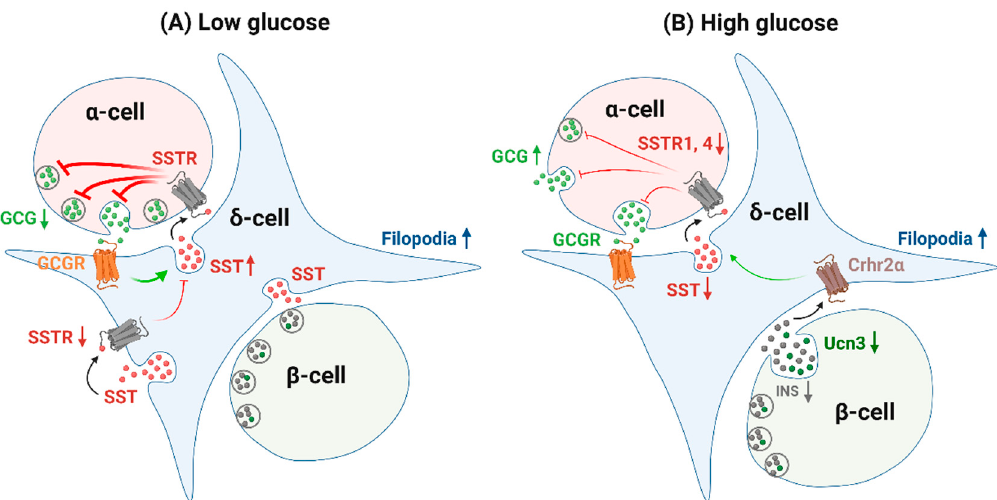
Figure 5. Paracrine crosstalk of δ -cells in diabetes. The expressions of somatostatin receptors (SSTRs) in islet cells are altered in diabetes with diminished levels of SSTR1 and SSTR4 in α -cells and SSTR1-4 in δ -cells. δ -cell filopodia length is increased in prediabetic and diabetic animal models to expand its contacts with α - and β -cells. ( A ) At low glucose, excessive somatostatin secretion is responsible for the defective counter-regulation of α -cells in diabetes with inadequate glucagon secreted in response to hypoglycemia. This may be due to the higher sensitivity of δ -cell to neighboring α -cell activity. ( B ) At high glucose, due to β -cell depletion and consequently reduced Ucn3 and insulin in diabetes, δ -cells lack the stimuli for sufficient glucose-induced somatostatin secretion (GISS), which could further lead to inappropriate glucagon release during high glucose. Green arrows indicate stimulation and red blunted arrows indicate inhibition. Line strength indicates strength of stimulation/inhibition. Note that the stimulation/inhibition of SST secretion is relative to its secretion at either low or high glucose under normal physiological conditions. GCGR, glucagon receptor; Crhr2, type 2 corticotropin releasing hormone receptor; SST, somatostatin; GCG, glucagon; INS, insulin; Ucn3, Urocortin3. Created by BioRender.com.